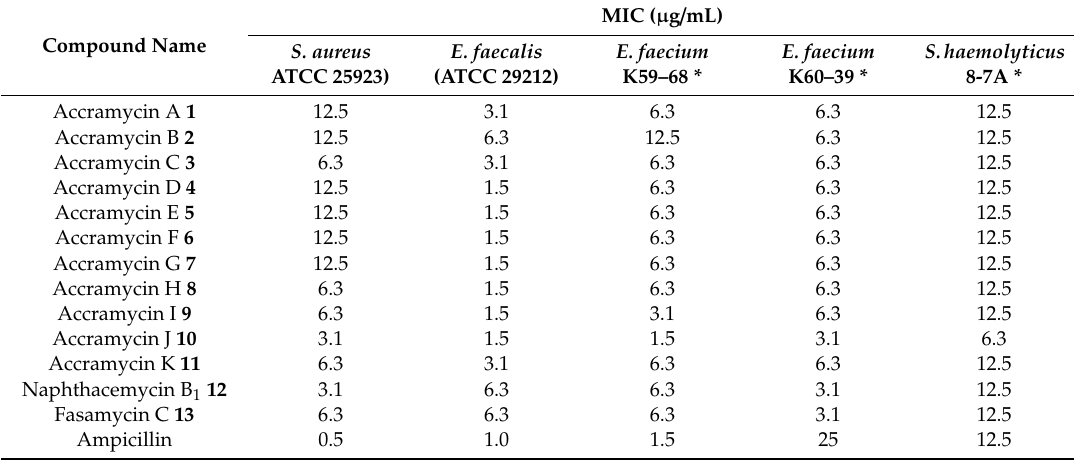
Table 1. Minimum inhibitory concentration (MIC) of compounds 1 –